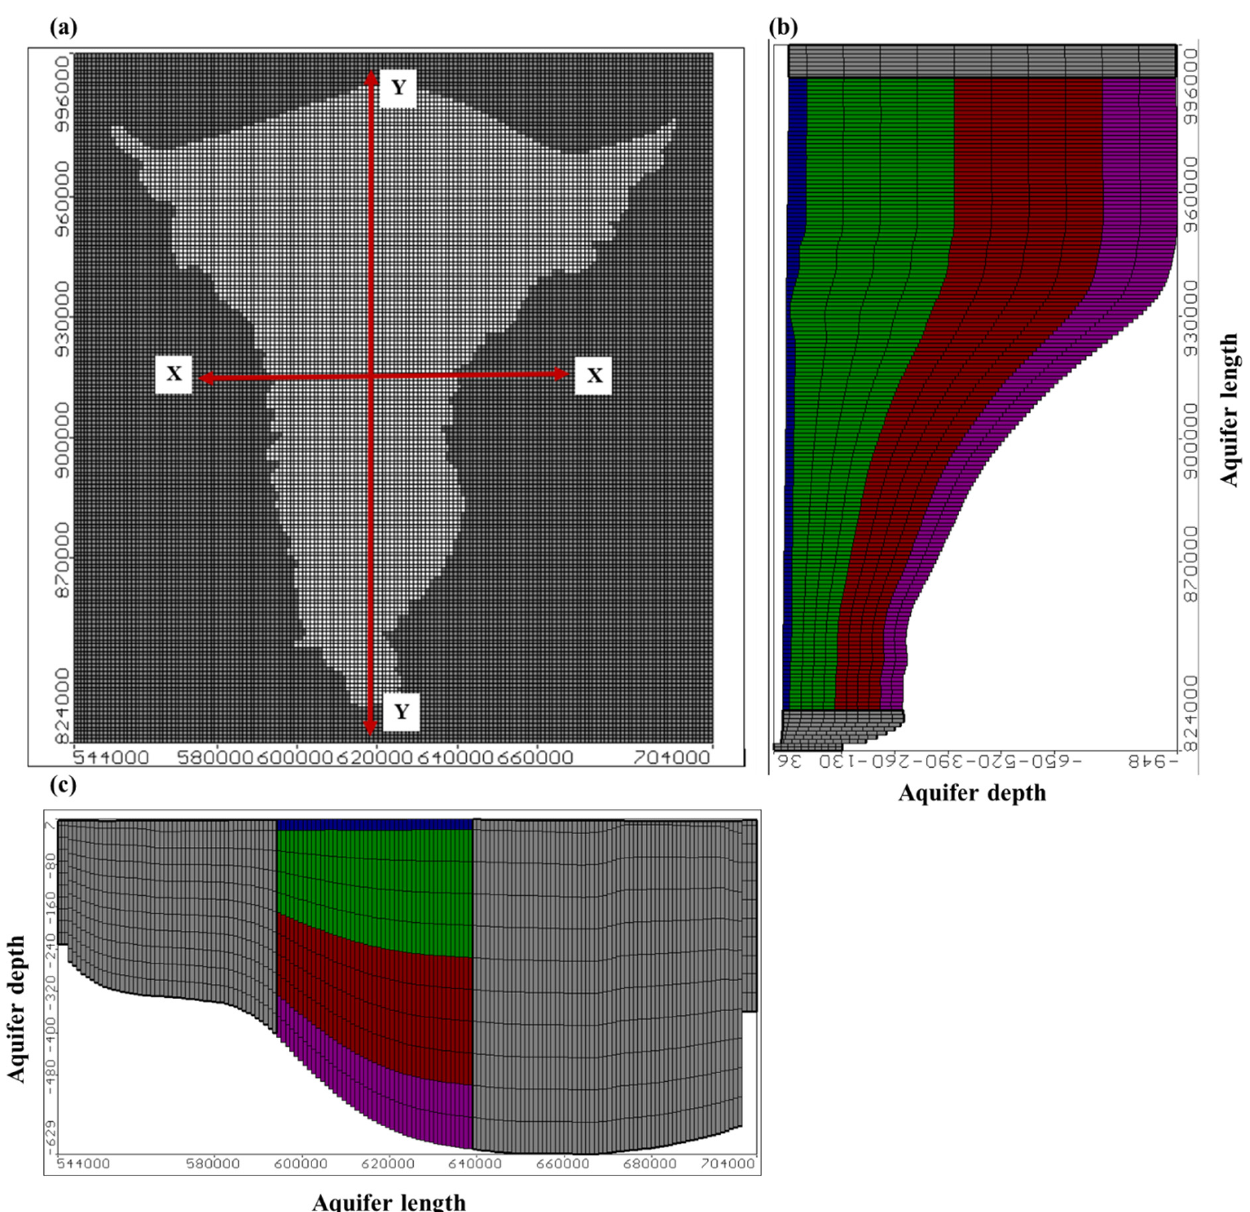
Figure 3. Model domain for MNDA, ( a ) model grid (white color indicates the active domain of middle Nile Delta area and dark gray indicates the inactive domain), ( b ) cross section in Y-direction, and ( c ) cross section in X-direction.